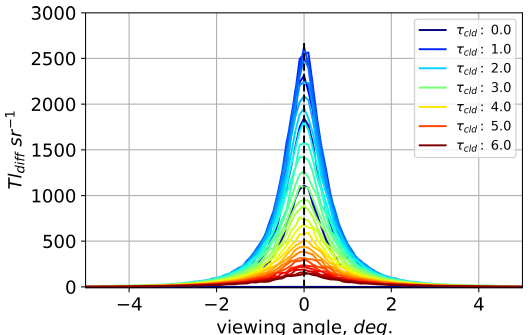
Figure A3. Relationships of τ cld vs. τ i for RS and RD (Eqs. A3 and A4) for the 500nm wavelength, with SZA ranging from 10–70 ◦